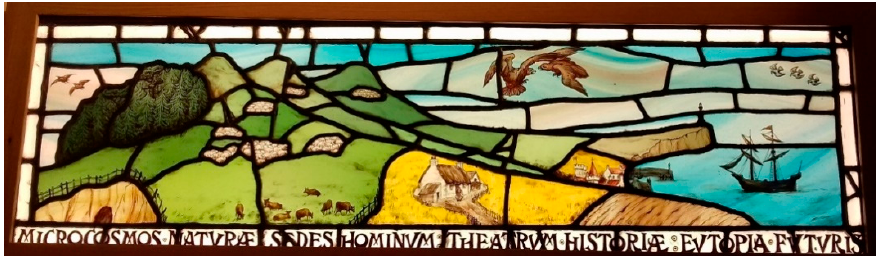
Figure 8. Valley Section, stained glass panel in Patrick Geddes Centre, Riddles Court, Edinburgh. Image, author’s own.